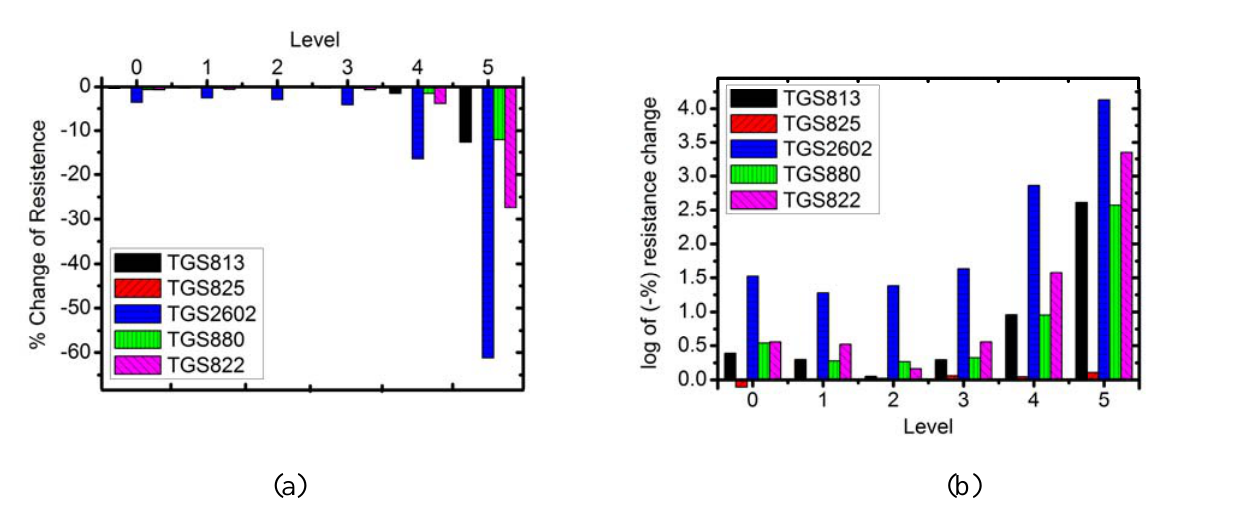
Figure 5. (a) Sensor response to isovaleric acid at different intensity level. (b) Logarithmic plot of the sensor